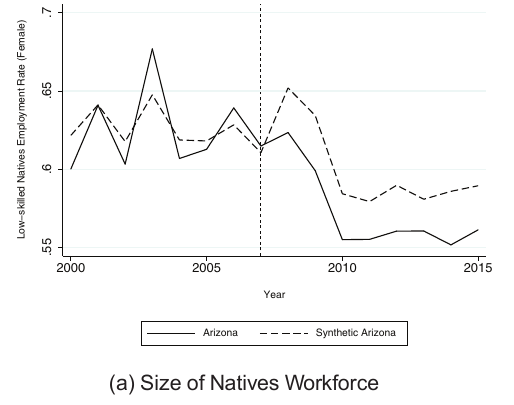
Figure A32 Low-skilled natives employment rate